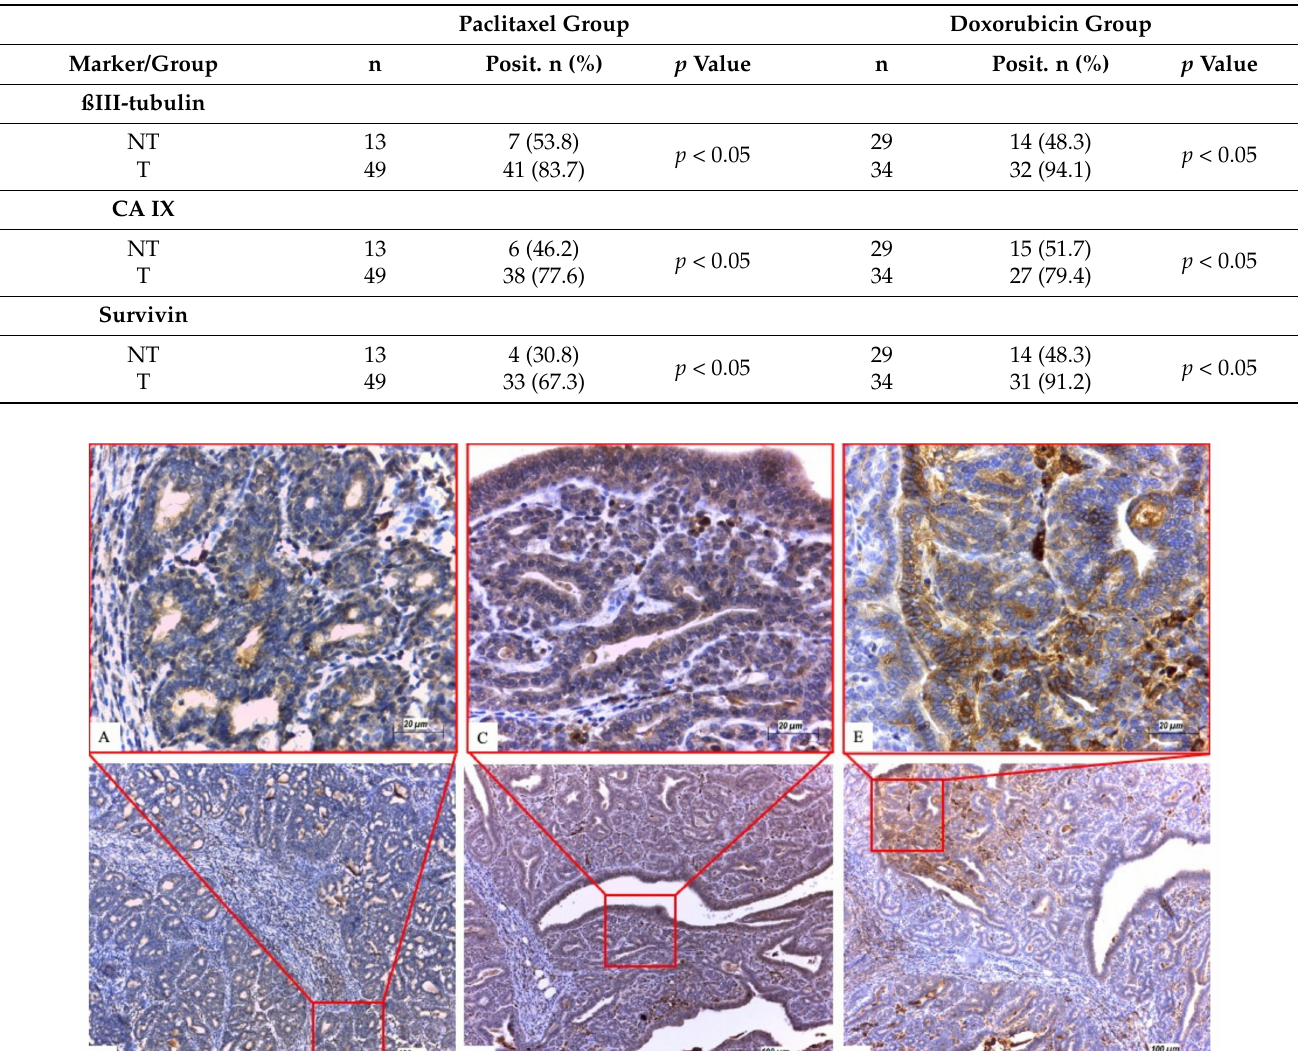
Table 4. Overall expression of markers in breast cancer tumor samples from non-treated (NT) and treated (T) groups of female rats.